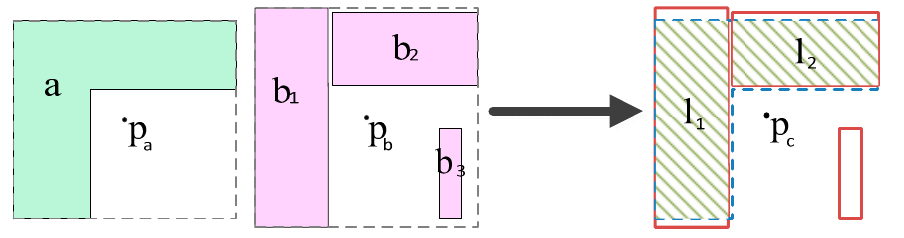
Figure 2. Overlapping area of 𝒂 and 𝒃 .